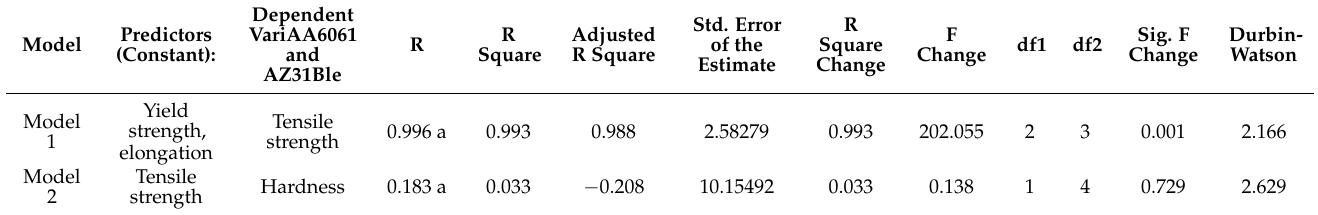
Table A2. Model summary describing the strength of relationship among variables.